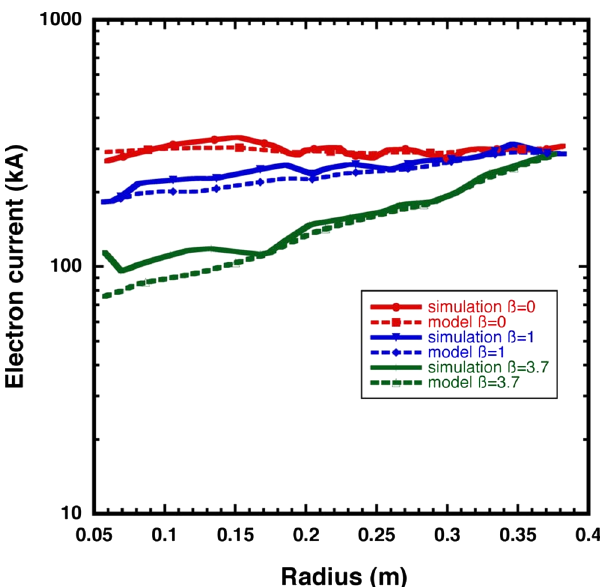
significantly.FIG. 6. (Color) Simulation electron flow for the (cid:2) ¼ 0 , 1, and 3.7 per meter radial profiles at high voltage (i.e., V ¼ 5 MV ). (cid:2) ¼ 0 represents constant electron flow. (cid:2) ¼ 1 m (cid:6) 1 represents a reduction of electron flow which decreases as 1 =e for every meter towards the load. (cid:2) ¼ 3 : 7 m (cid:6) 1 represents the highest retrapping rate